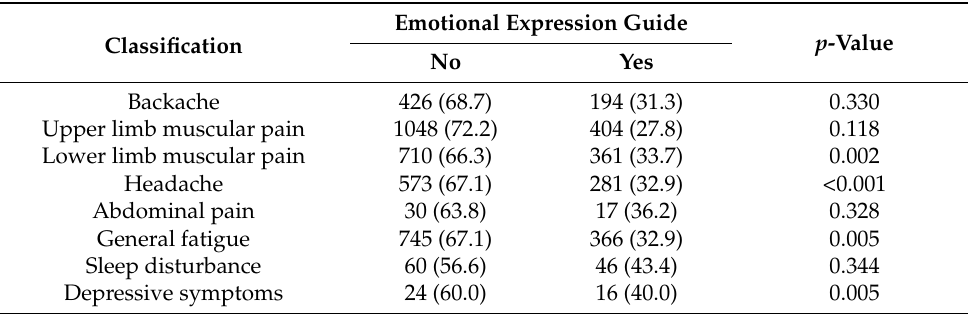
Table 2. Prevalence of work-related health problems according to the existence of an emotional expression